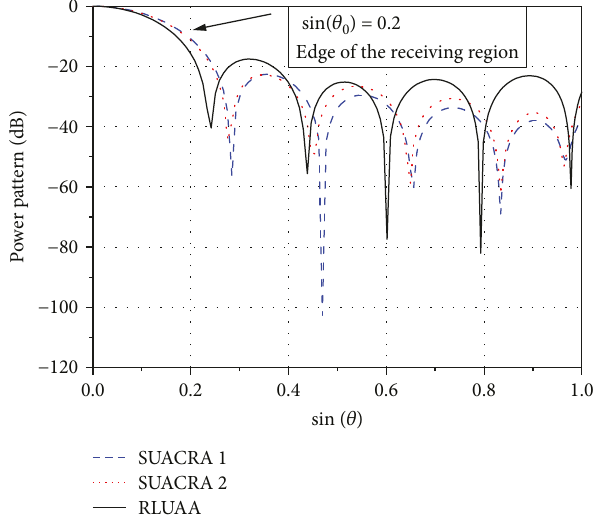
Figure 5: Power patterns ( φ =0) comparison of SUACRA 1, 2, and the RLUAA.